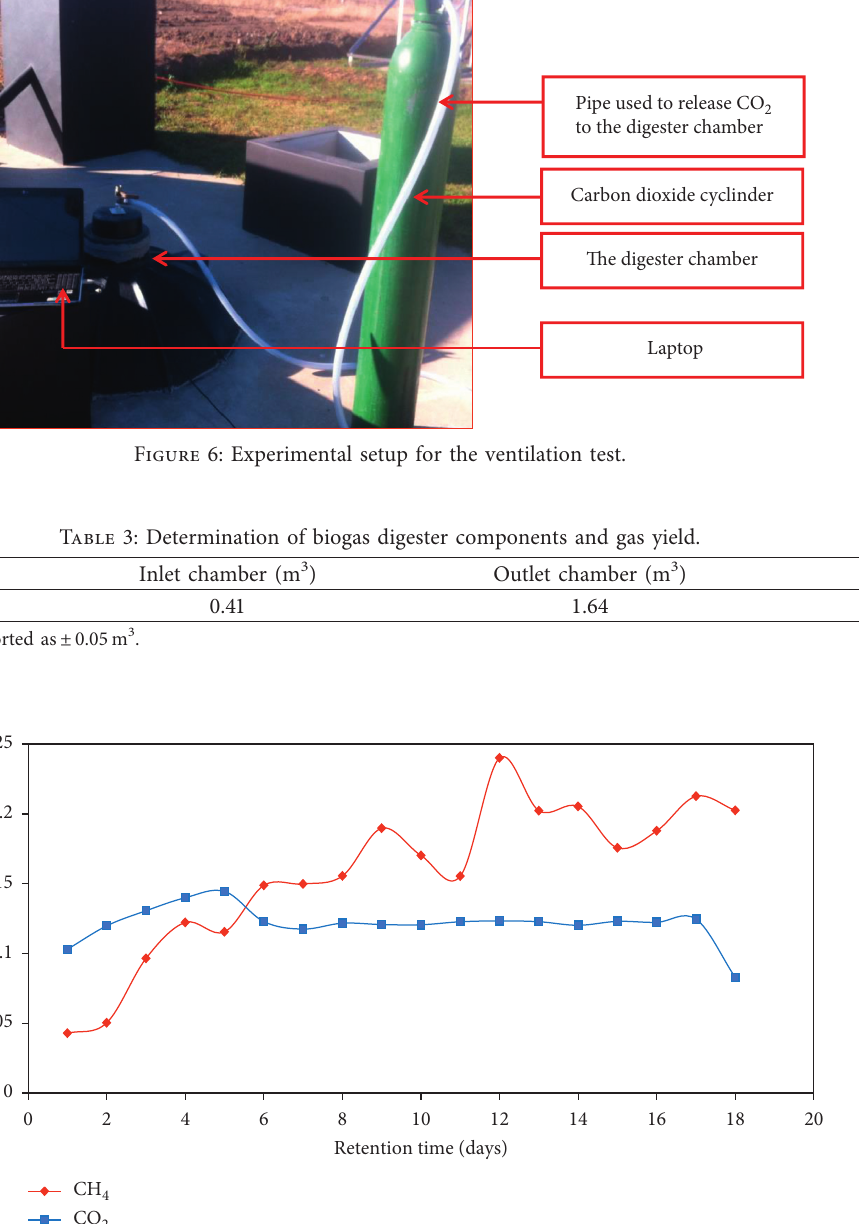
Figure 7: Biogas yield profile against time for the biogas digester [13].